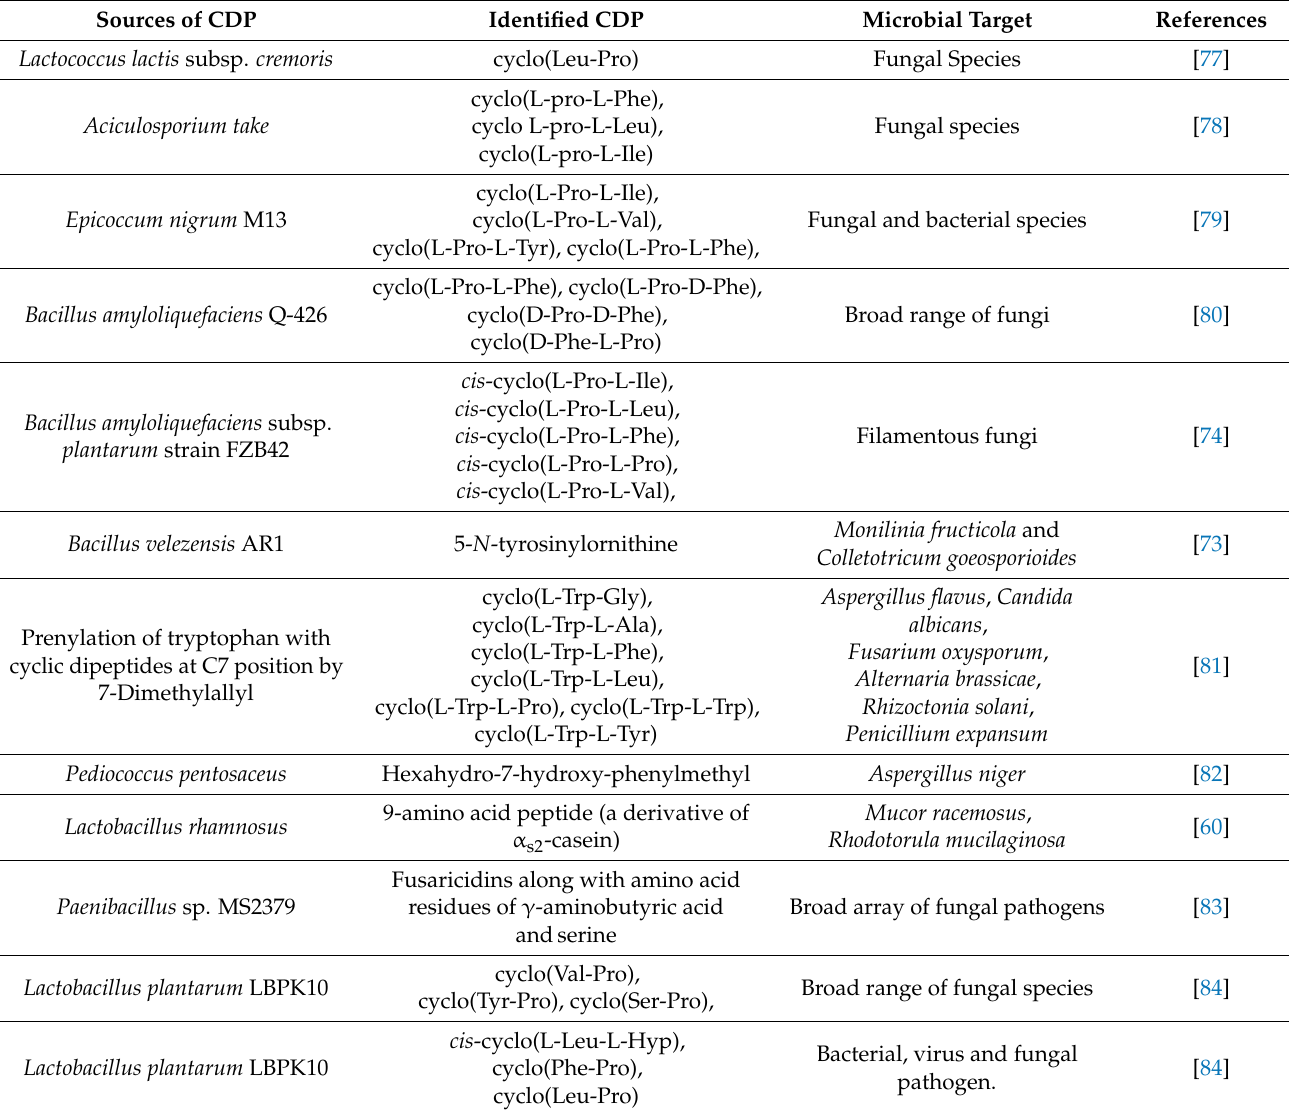
Table 3. Cyclic dipeptides identified as antifungal